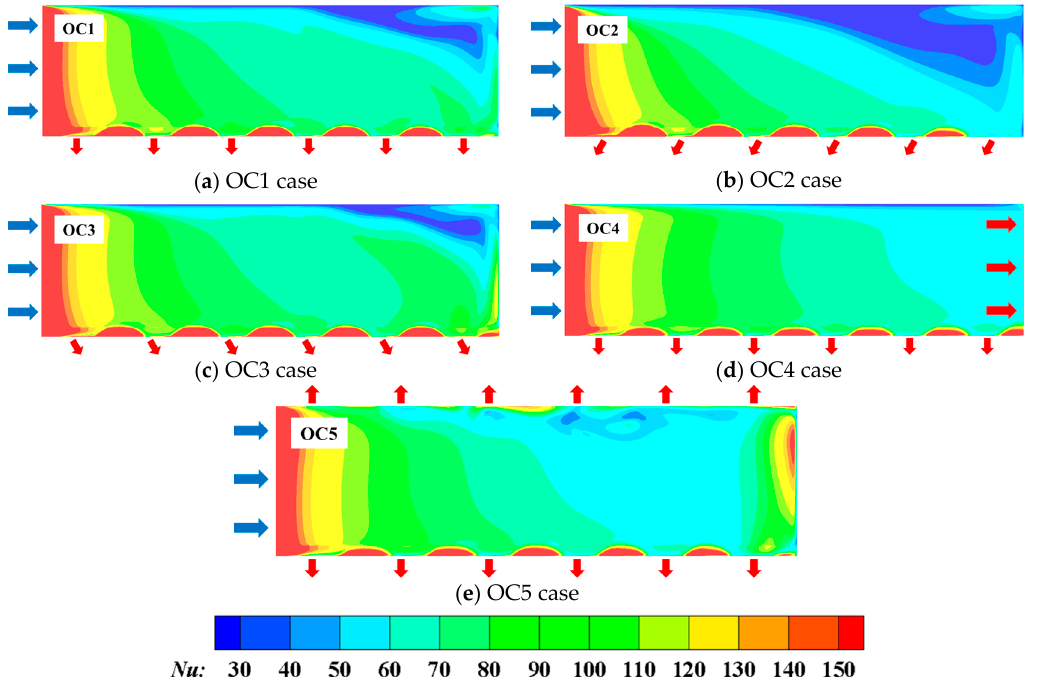
Appl. Sci. 2019 , 9 , x FOR PEER REVIEW 10 of 16 Figure 7. Nusselt number distributions on the endwalls for different outlet configurations, Re = 30,000. Figure 7. Nusselt number distributions on the endwalls for di ff erent outlet configurations, Re = 30,000.